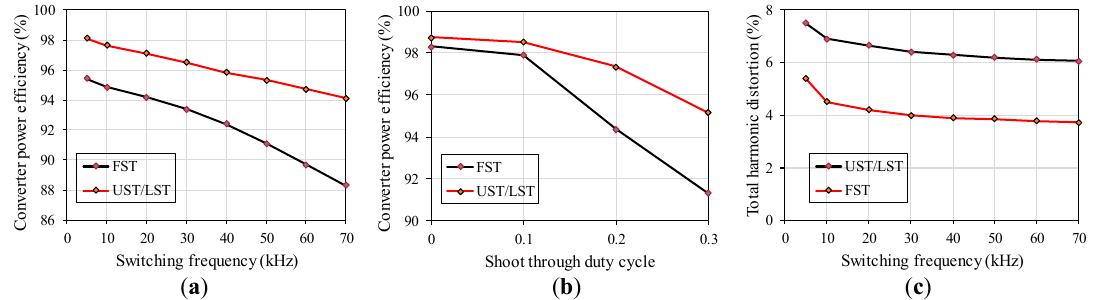
Figure 9. Performance comparisons between the classical FST strategy and the proposed UST/LST strategy: ( a ) Efficiency versus switching frequency; ( b ) Efficiency versus shoot-through duty cycle; ( c ) Total harmonic distortion versus switching frequency.